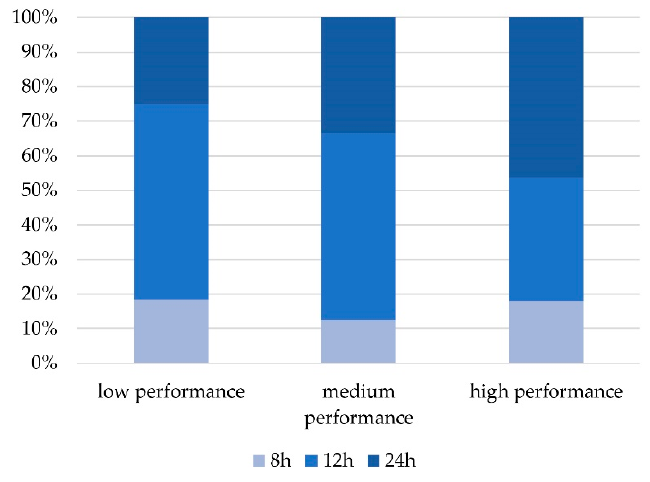
Figure 16. Opening hours by performance category.